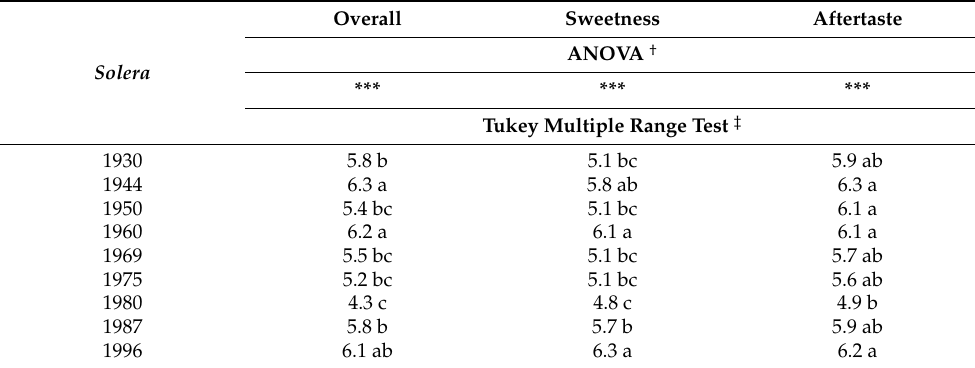
Table 5. Affective sensory analysis of Fondill ó n wines as affected by the “ solera ” factor. Overall Sweetness Aftertaste Solera